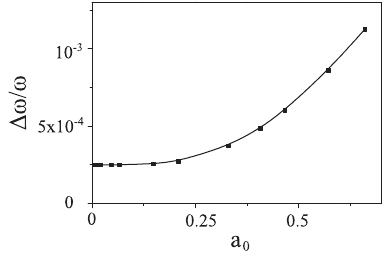
FIG. 2. Rms spectral bandwidth (cid:3) !=! on axis as a function of the laser parameter a 0 . Other parameters have the same values as in Fig. 1.